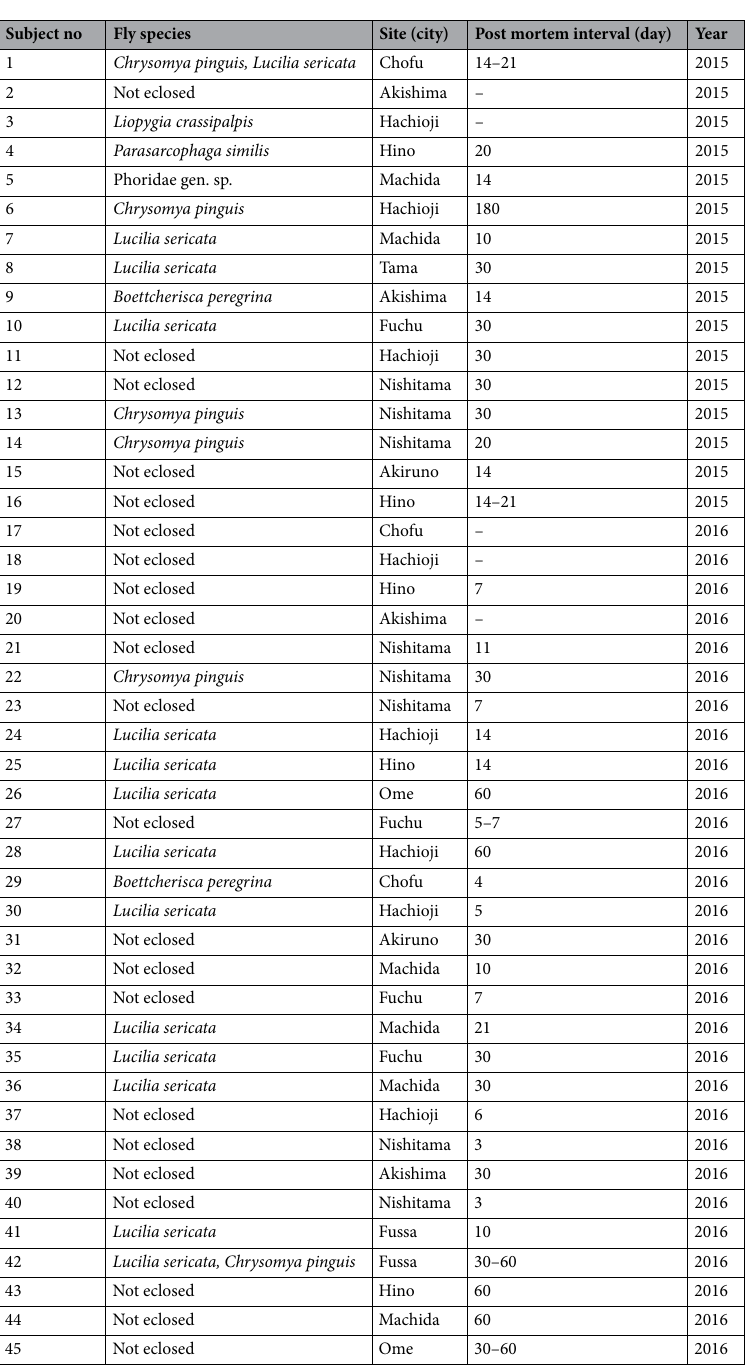
Table 1. Specimens of fly larvae collected from forensic corpses in Western Tokyo (Tama area), Japan, from 2015 to